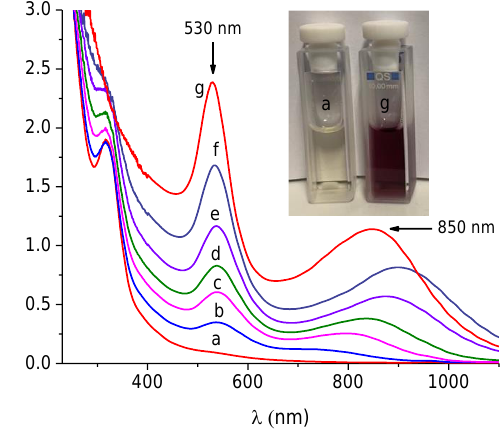
Figure 1. Absorption spectral evolution from 0 min (a) to 6 h (g) observed for an aqueous solution of PolyCD (2 mg mL −1 ) containing PSE (4.5 mg mL −1 ) in the presence of HAuCl 4 (0.4 mM). The inset shows the actual image of the sample a and g, respectively. T = 25 °C.